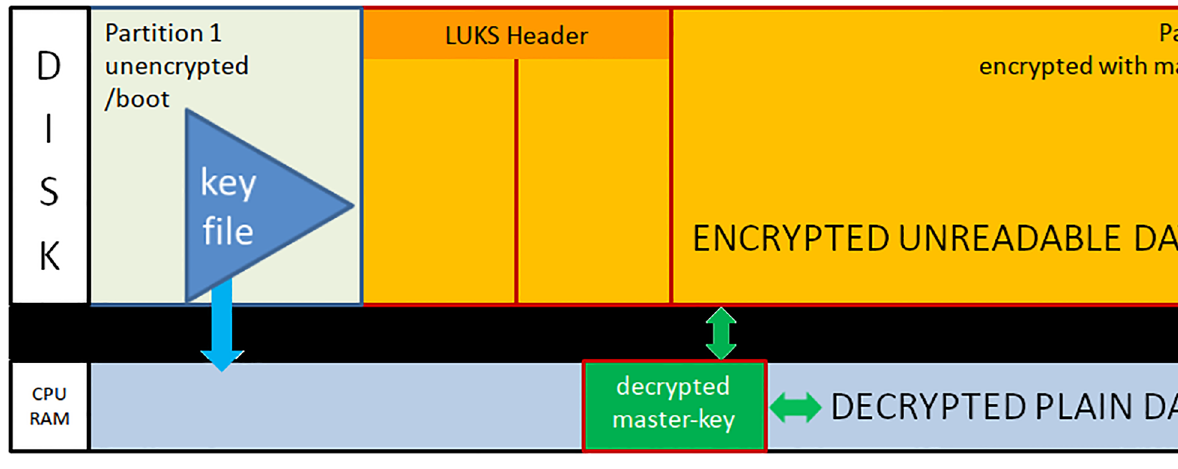
Fig 4. Sealed operational